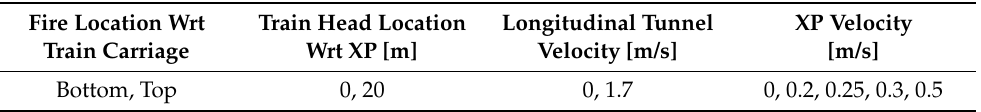
Table 1. Summary of the fire locations, train heat locations, longitudinal tunnel and cross-passage (XP) velocities of all case studies.